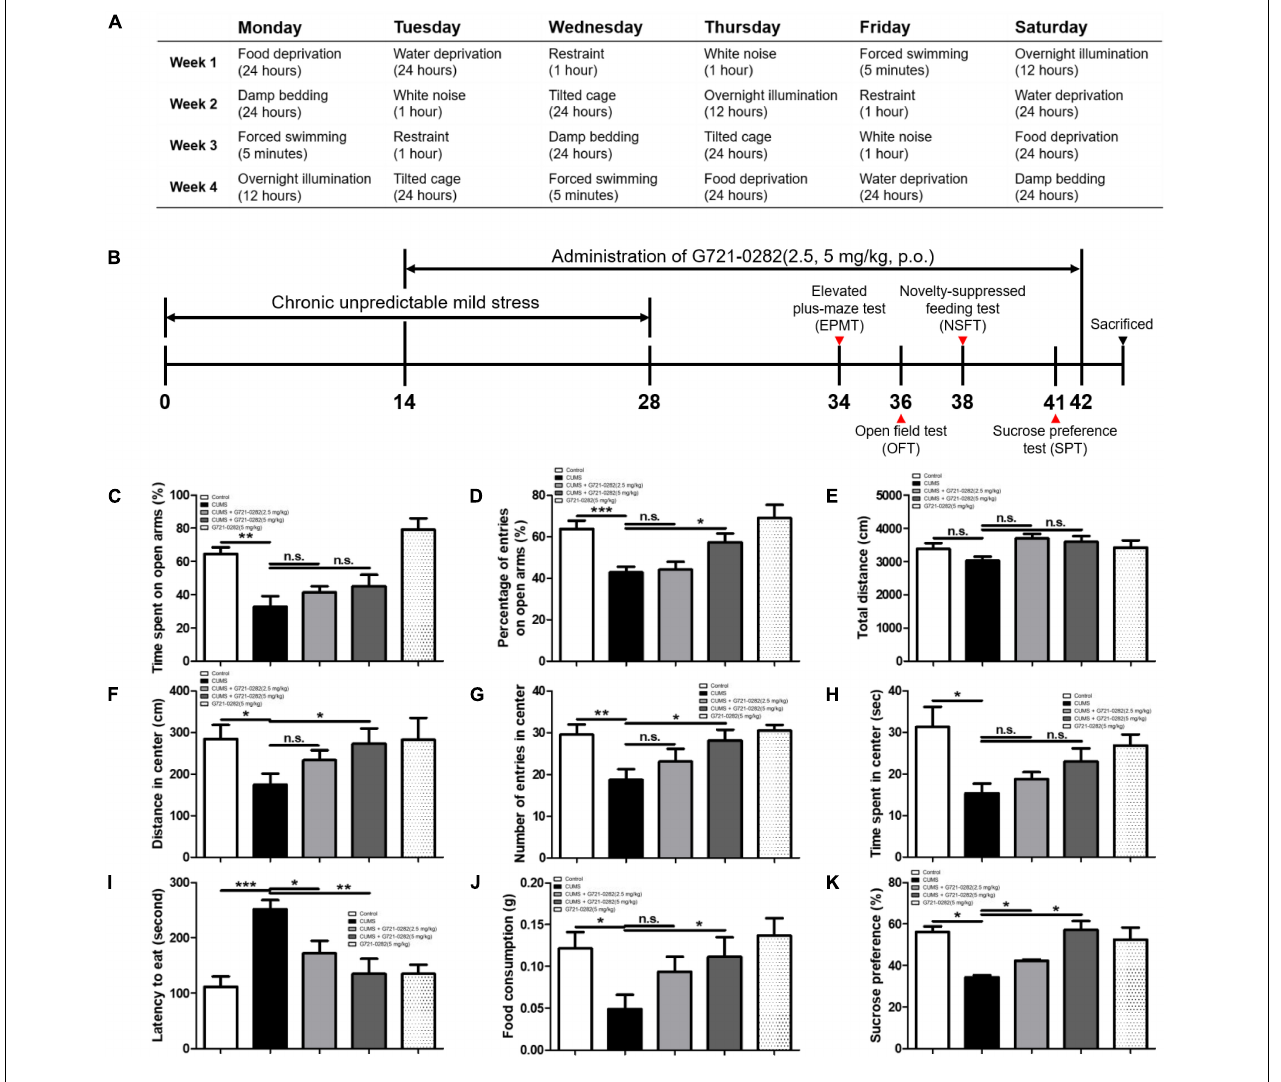
FIGURE 2 | Anxiolytic-like effect of the G721-0282 on CUMS-induced anxiety behaviors in BALB/c mice. A table have been described that the daily CUMS schedule and the stressors used in the CUMS procedures (A) . A timeline have been described that demonstrate the administration of G721-0282 and the serial assessment of anxiety in BALB/c mice (B) . To investigate the anxiolytic-like effect of G721-0282, we carried out the EPMT (C,D) , OFT (E–H) , NSFT (I,J) , and SPT (K) . Anxiety level in BALB/c mice was determined by time spent on open arms ( C , %) and the number of entries on open arms ( D , %) in the EPMT, by distance in center ( F , cm), the number of entries in center ( G , counts), and time spent in center ( H , s) in OFT, by latencies to eat ( I , s) and food consumption ( J , g) in NSFT, and by sucrose preferences ( K , %) in SPT. ∗ , Significantly different between two groups ( p < 0.05). ∗∗ , Significantly different between two groups ( p < 0.01). ∗∗∗ , Significantly different between two groups ( p <